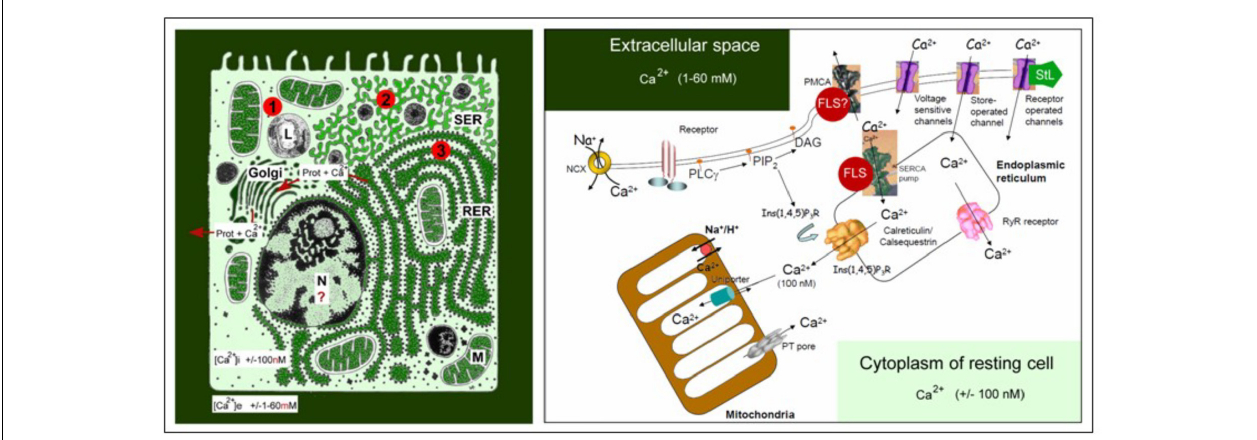
FIGURE 1 | Schematic representation of the main Ca 2 + gradients in eukaryotic animal cells (left panel) and of the main players in Ca 2 + -homeostasis (right panel). Left: Schematic representation of the Ca 2 + gradient (adapted from De Loof, 2015, 2017: Copyright permission not required). The different shades of green are not meant to give an exact representation of differences in Ca 2 + -concentration. L, lysosome, N, nucleus; M, mitochondrion; RER, rough endoplasmic reticulum; SER, smooth endoplasmic reticulum. The red dots with 1, 2, and 3 correspond to the main mechanisms for keeping [Ca 2 + ]i low. (1) Little influx of Ca 2 + through the plasma membrane that can be countered by the activity of Ca 2 + -ATPases in the plasma membrane (PMCAs); (2) more influx and role for temporary storage of Ca 2 + in membrane-limited organelles, in particular the SER; (3) high influx of Ca 2 + triggers the removal of excess Ca 2 + through the secretion of Ca 2 + -binding/transporting proteins via the RER. From De Loof (2017). Right: The major actors in the Ca 2 + -homeostasis system (slightly modified after Orrenius et al., 2003). The long legend as originally formulated by Orrenius et al. (2003) is not repeated here. It can be consulted in the Open Access paper by De Loof (2017). With thanks for the copyright permission for using the original figure and the legend from the publisher (Nature) and from Prof. S. Orrenius, both granted in